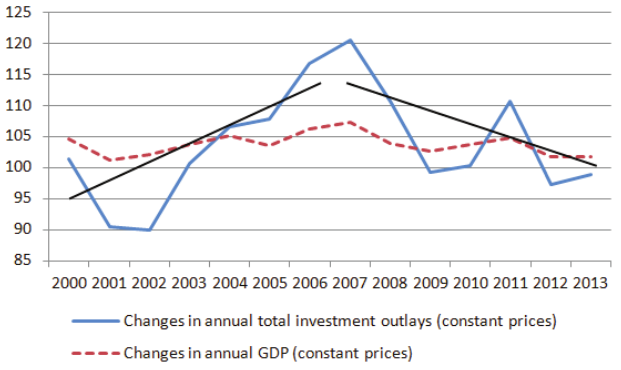
Fig. 2. Comparison of changes in GDP and investment outlays in Poland (Mar - ciniak et al. , 2015). Project-based companies that are executors of investments or providers of advertisements and consulting services are affected by the above-mentioned changes in a different scope and time, depending on the organisation type (Table